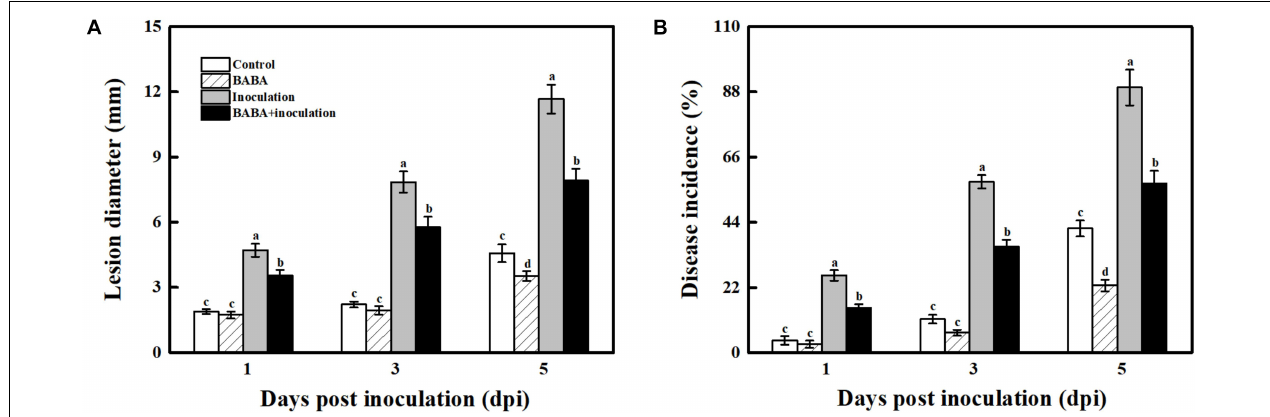
FIGURE 1 | Impact of BABA on the disease development of grapes altered in their responses to the fungal pathogen B. cinerea . Lesion diameter (A) and disease incidence (B) measured at 1, 3, and 5 days post inoculation with B. cinerea . Grapes were pretreated with water (gray bars) or BABA (black bars) before inoculation. Disease development is expressed as the mean ± SE of nine assessments. Different letters above the bar indicate a significant difference ( p < 0.05) between grapes with BABA-treated or B. cinerea -inoculated and untreated